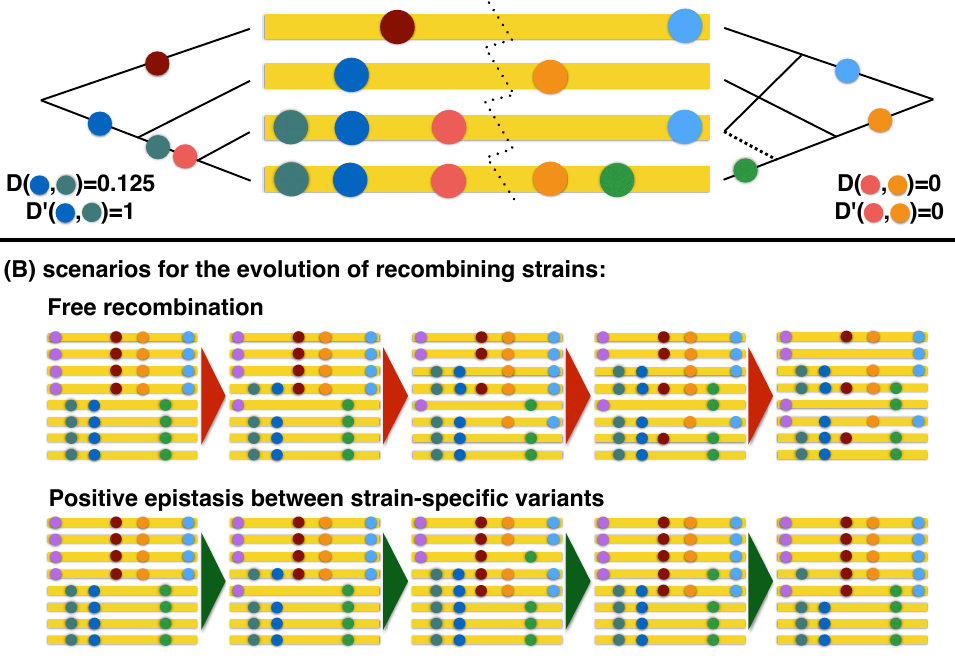
Figure 1. ( A ) Schematic illustration of the effect of a recombination event on sequences and SNPs. Each mutation occurs at most once along the tree. The left part of the sequence comes from a single genealogical tree and all variants are either strongly associated to each other or completely disjoint, hence there is complete linkage disequilibrium ( | D (cid:48) | = 1). The SNPs in the example have frequencies 0.5 and 0.75 and overlap in 50% of the sequences, hence D = 0.5 − 0.5 × 0.75 = 0.125. Since the overlap is also the largest possible one for these frequencies, max ( D ) = 0.125 and D (cid:48) = 1. The recombination event in the middle of the sequence changes the genealogy (as can be be seen in the genealogical tree on the right, the event prunes the dashed branch and regrafts it elsewhere). Variants in the right part of the sequence are unrelated to the ones across the recombination event, i.e., the presence of one variant in a sequence is not informative about the presence of the other, and linkage disequilibrium is much reduced ( | D (cid:48) | < 1). In the example, the two variants both have frequency 0.5 but their frequency of overlapping is 0.25, hence D = 0.25 − 0.5 × 0.5 = 0. The maximum overlapping frequency would be 0.5, hence max ( D ) = 0.5 − 0.5 × 0.5 = 0.25 and D (cid:48) = 0. ( B ) Schematic illustration of the two extreme scenarios for recombination, starting with a mixture of two strains. In the case of freely recombining sequences, the number of recombinants increases steadily with time. The inferred recombination rate corresponds to R = r · t where r is the recombination rates and t is the sampling time elapsed after the strains were mixed. In the epistatic case, if the fitness of the recombinants is 1 − s times the fitness of the original strains, their number increases slightly until it reaches a stationary value determined by the recombination-selection balance and proportional to the ratio r / s . The inferred recombination rate at equilibrium corresponds to R ≈ r / s